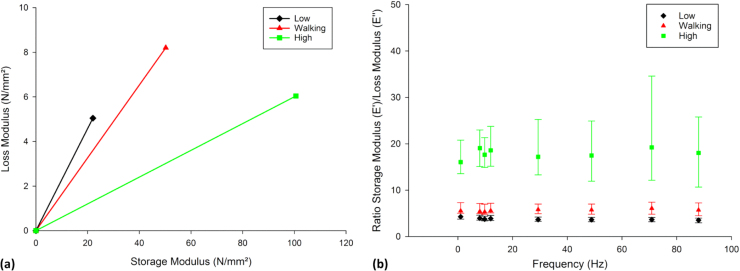
Effect of stress on storage and loss moduli. (a) Argand diagram showing the storage and loss moduli of articular cartilage tested at low, walking and high stress ranges. The plotted lines demonstrate the mean magnitude of the complex modulus (E*) of the low, walking and high stress ranges at 1 Hz; the Argand diagram illustrated here is similar to other specimens as well as different frequencies. (b) Ratio of storage modulus/loss modulus of articular cartilage tested between at low, walking and high stress ranges (median ± 95% confidence intervals; n = 8). The raw data used in Fig. 2 is also used in Fig. 4b, however, Fig. 4b is not derived directly from Fig. 2.